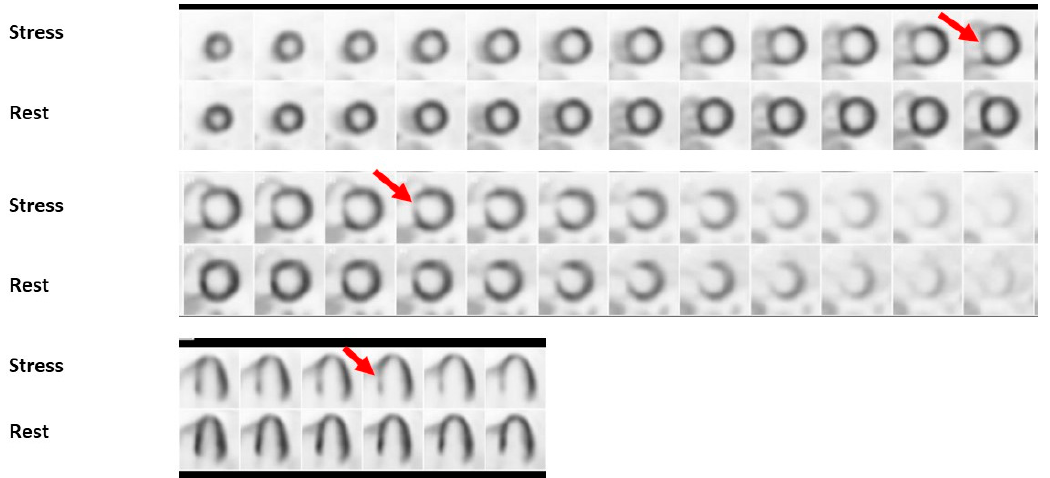
Figure 2. shows a regadenoson myocardial perfusion PET/CT study using 13-N ammonia tracer. A large perfusion defect of moderate intensity primarily involving the mid-basal septal LV segments with extension to the mid-basal anterior LV segments, which appeared completely reversible, is visible (red arrows). There was also a medium-sized, mild perfusion defect involving the true LV apex and apical LV segments, which appeared reversible.